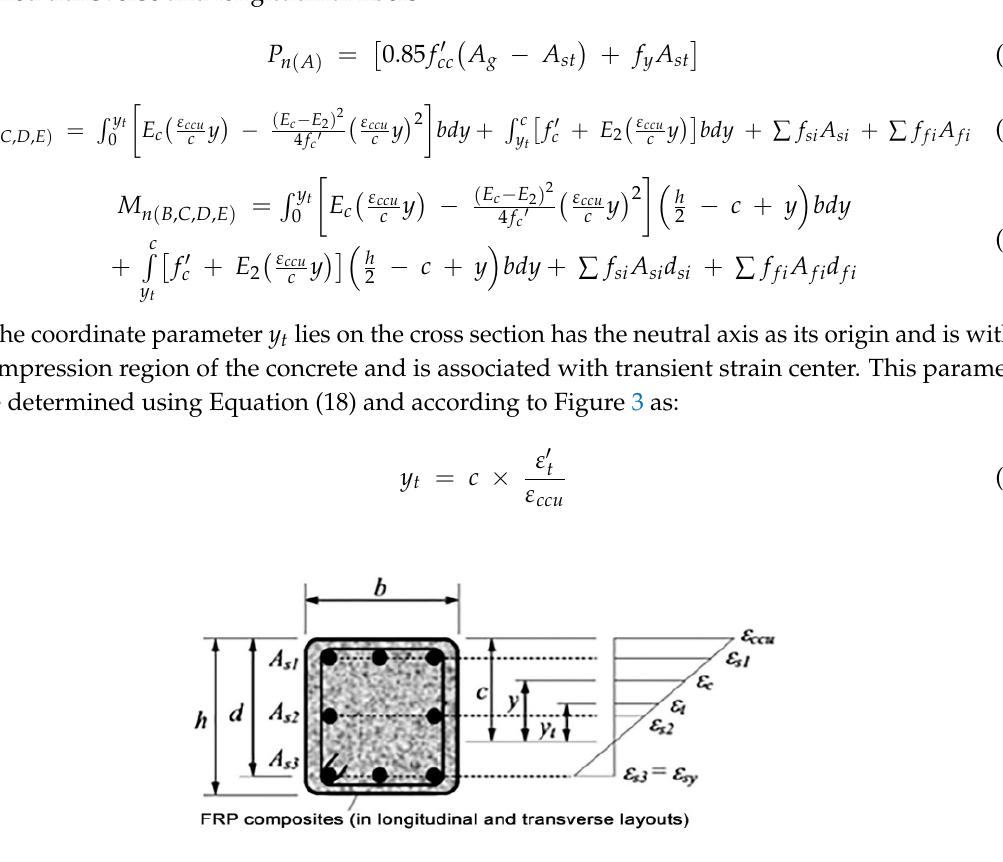
Figure 3. Strain distribution diagram in the section.